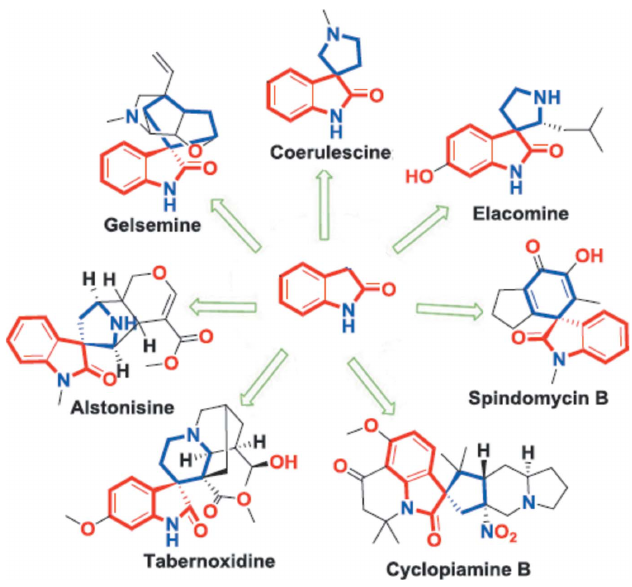
Figure 1 Natural products containing the spirooxindole motif.